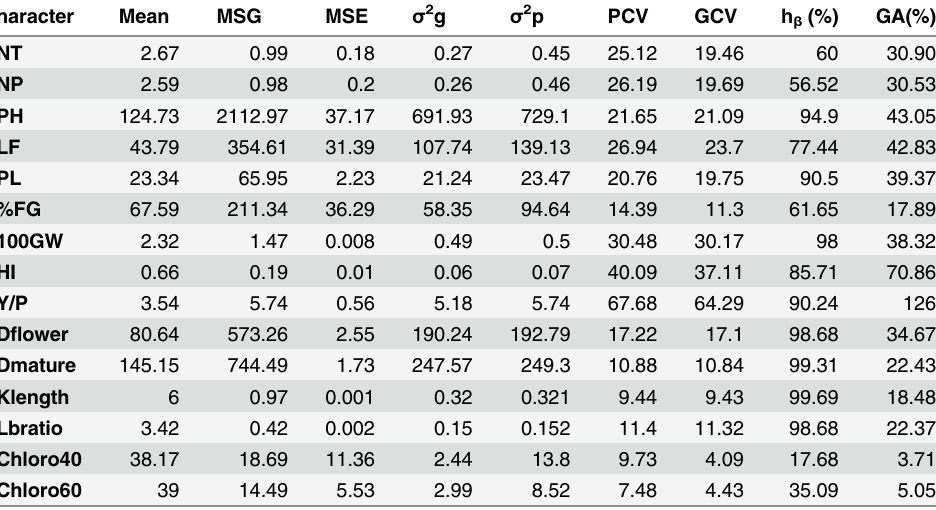
Table 8. Genetic parameter calculated among 15 agro-morphological traits. haracter Mean MSG